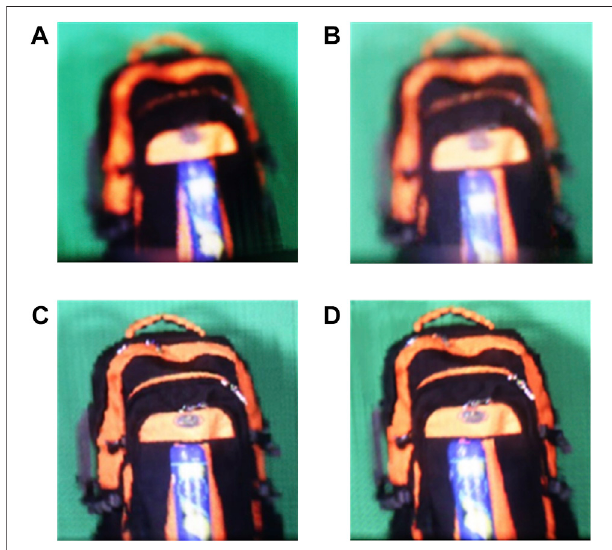
FIGURE 13 | Three-dimensional reconstruction results. SPOC algorithm: (A) left 7.1 ° viewing angle and (B) right 7.1 ° viewing angle. Average SPOC algorithm: (C) left 7.1 ° viewing angle and (D) right 7.1 ° viewing